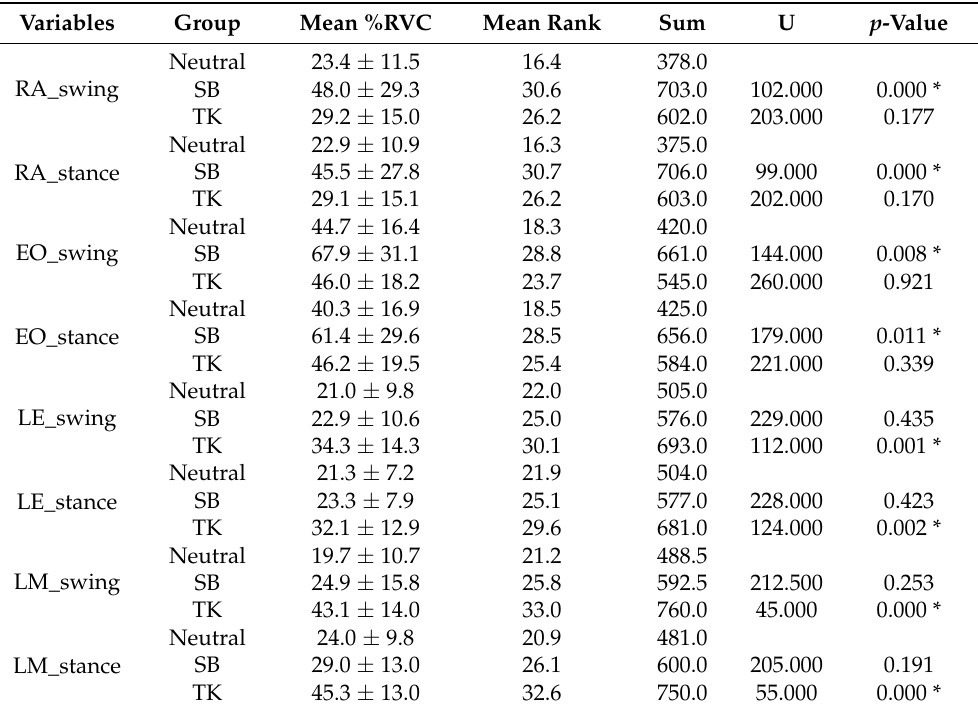
Table 4. Comparison of the activity of four trunk muscles according to gait posture, analyzed by the Mann-Whitney U test ( n =